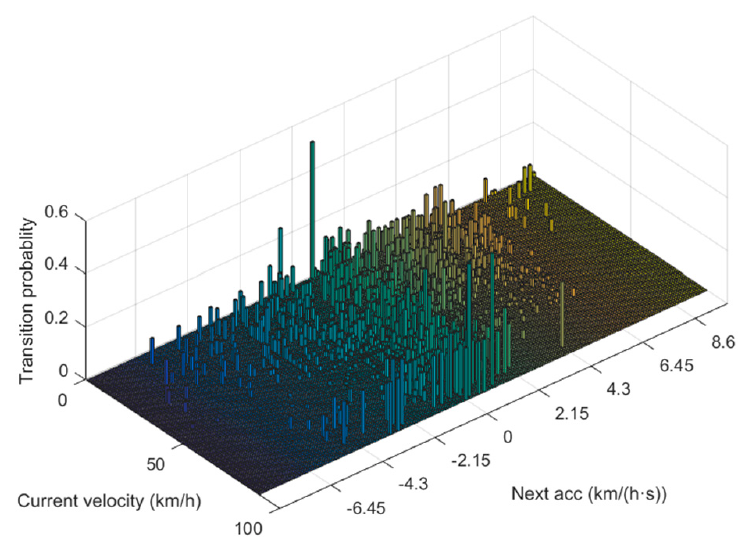
Figure 6. Transition probability map of city conditionz.